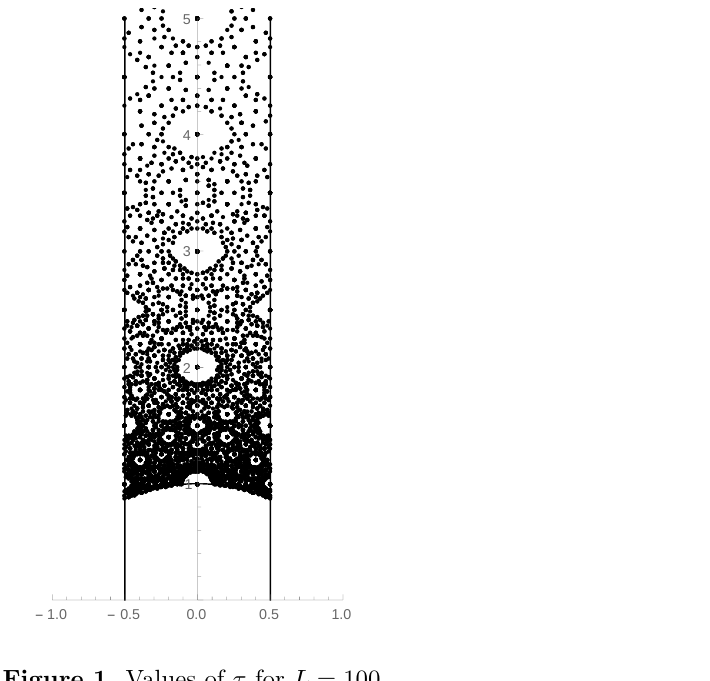
Figure 1 . Values of (cid:28) for L =